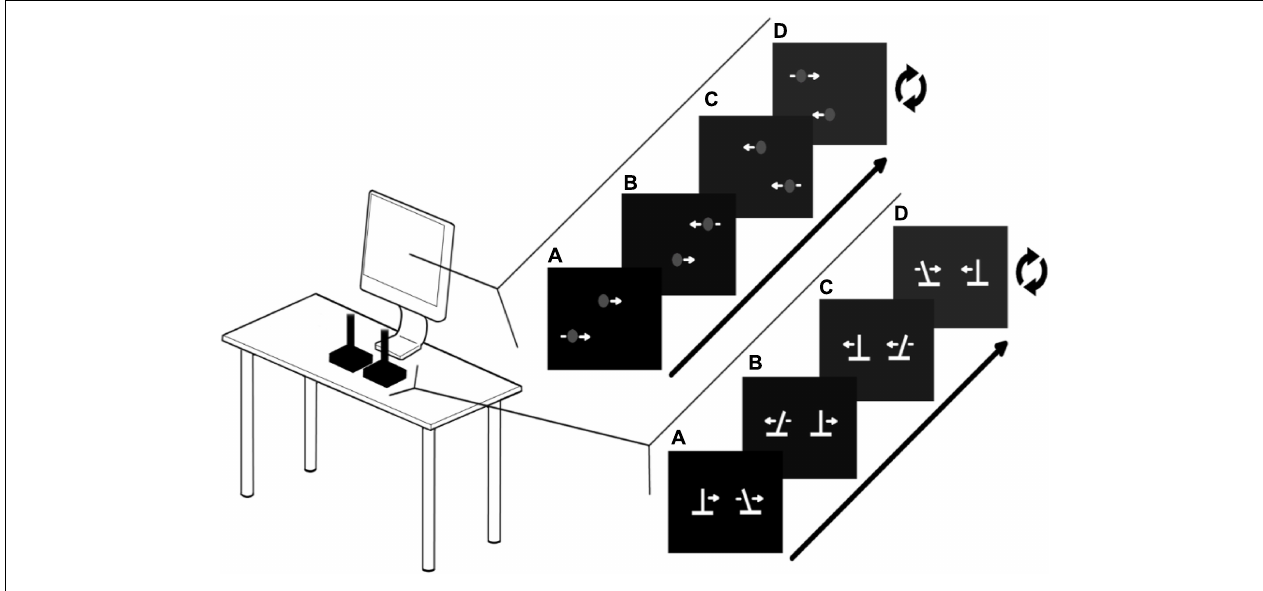
FIGURE 1 | Experimental setup : Action sessions. Participants use both joysticks to control the horizontal movements of the dots on the computer display. The visual display on the computer screen (A) corresponds with the position of the joysticks (A). The figure shows an example of moving at 60 ◦ . This is achieved by moving linearly from A to D and repeating. During the training sessions, moving at 60 ◦ ± some error triggers the hot-cold signal in which the white dots turn green (grey in figure; see Coordination Feedback).